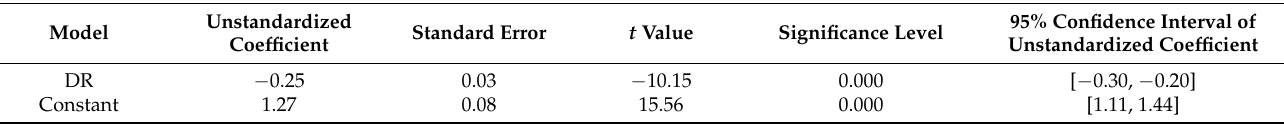
Table 3). The standardized residual value ranged from − 1.78 to 1.70. There was a significant linear relationship between TS and DR (Figure 3). Table 3. The linear regression model of the temporary stability (TS, dependent variable) built by dominant tree richness (DR, independent variable).